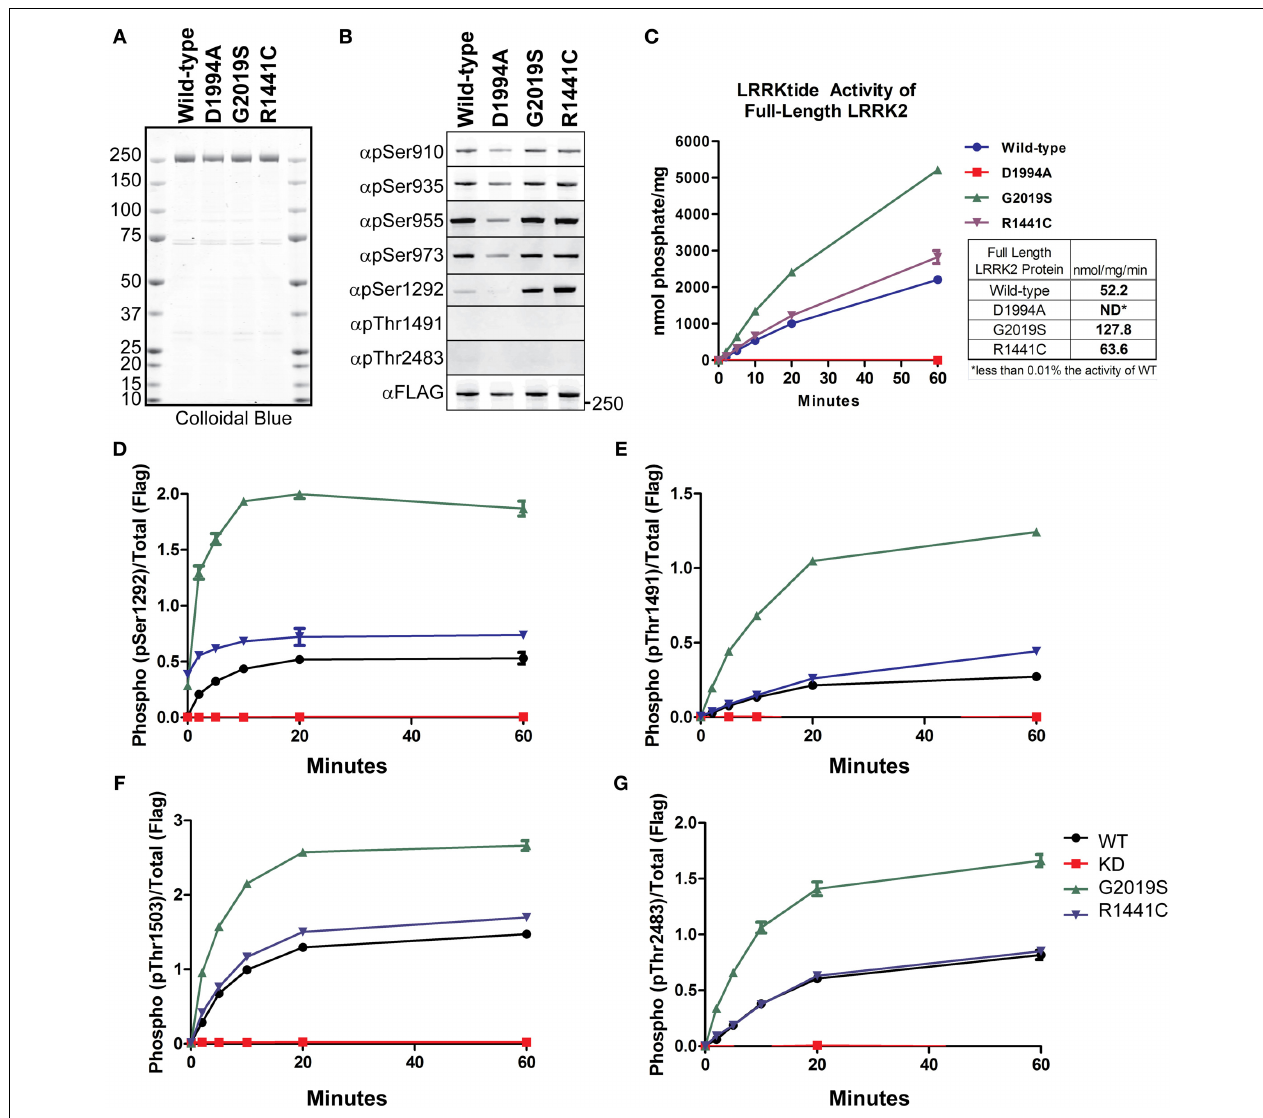
FIGURE 1 | Detection of autophosphorylation and cellular phosphorylation sites on recombinant LRRK2. The indicated full-length recombinant LRRK2 proteins were resolved by SDS-PAGE and stained with either (A) Colloidal Blue to quantify relative protein levels or (B) the indicated phospho-specific antibodies. (C) 14nM of recombinant wild type LRRK2 (WT) or mutant LRRK2 [Asp1994Ala, Gly2019Ser, Arg1441Cys] in vitro kinase activity was measured against LRRKtide. Incorporated 32 P was assessed by Cerenkov counting and results are representative of three independent